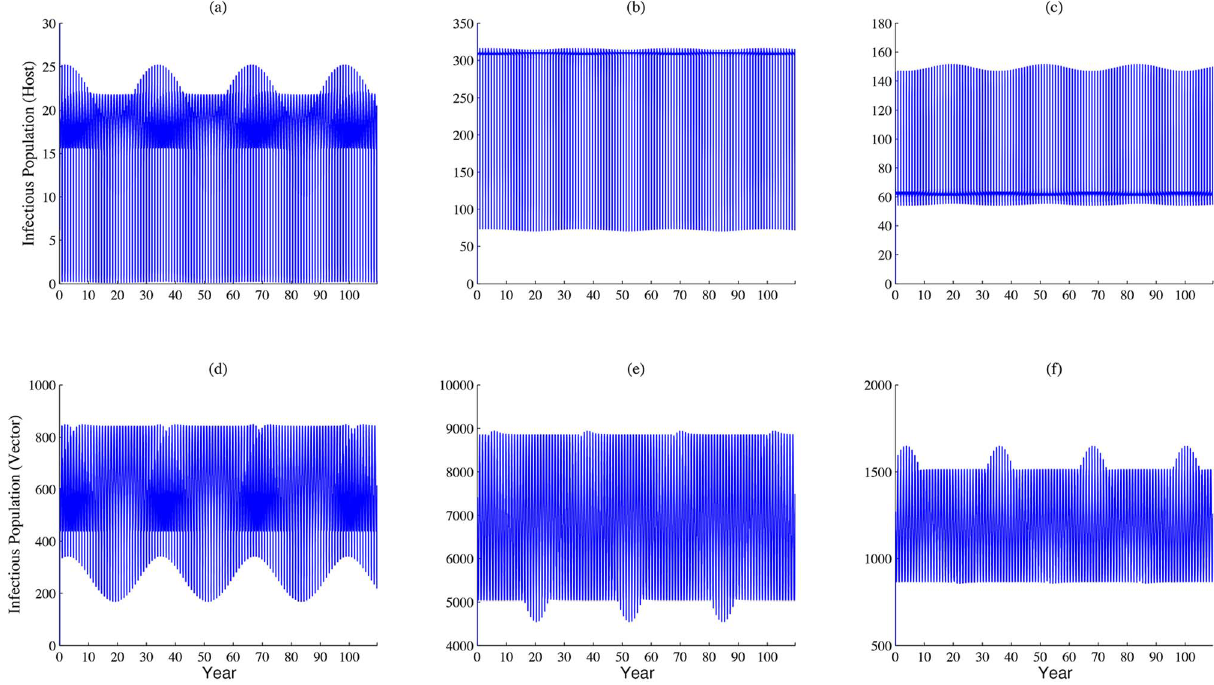
Fig. 6. Long term dynamic of disease outbreaks. (a), (b) and (c) represent the populations of infectious livestock, (d), (e) and (f) represent sizes of the infectious mosquito population in patches 1, 2 and 3, respectively. Values of parameters are the same as those used in Fig. 3. We can observe that there is a large scale of disease outbreak around every 30 years, within the festival season.